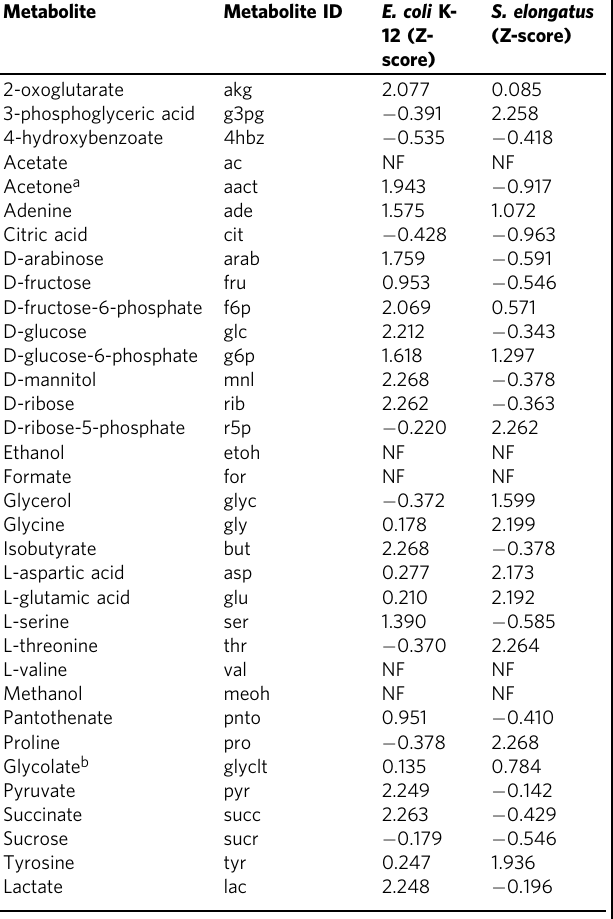
Table 3 Intracellular metabolite Z-score comparisons from